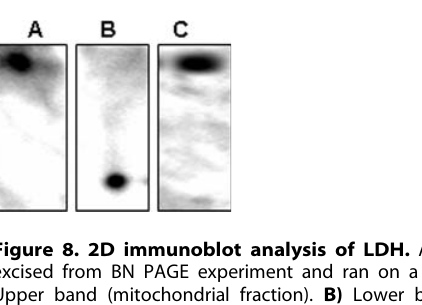
assessed by immunoblotting for Cyt C (intermembrane space protein) and SDH (mitoplast protein) (Figure 9II). Immunoblot analysis of the two mitochondrial compartments using an anti- LDH1 antibody revealed the occurrence of LDH1 in the mitoplast fraction suggesting that this isoenzyme preferentially localizes to the inner mitochondrial/matrix compartment (Figure 9I).